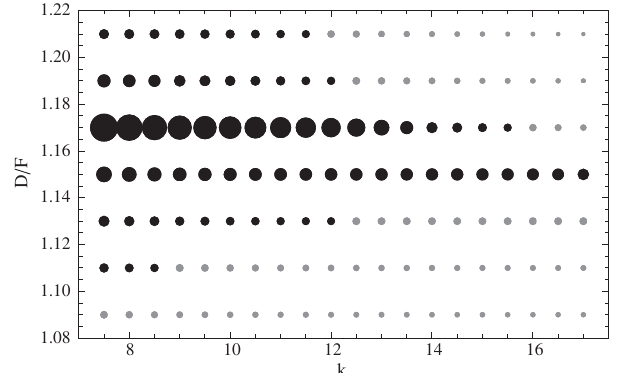
FIG. 53. The acceptances for 30 m of transport line using cells with nonscaling magnets in a DFFD configuration, k=x 12 and D = F close to 1.15. For scale, the largest dot at k=x and D = F ¼ 1 : 17 represents an acceptance of 122 : 03 (cid:8) mm mrad . See Fig. 50 for description of dot size and